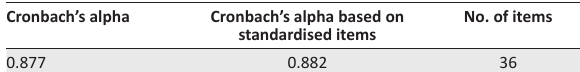
TABLE 1: Reliability statistics.